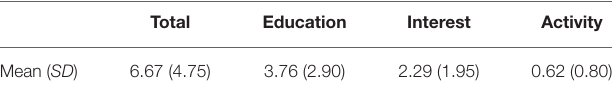
TABLE 4 | The mean scores (SD) for the total and the three subscales of Art Experience